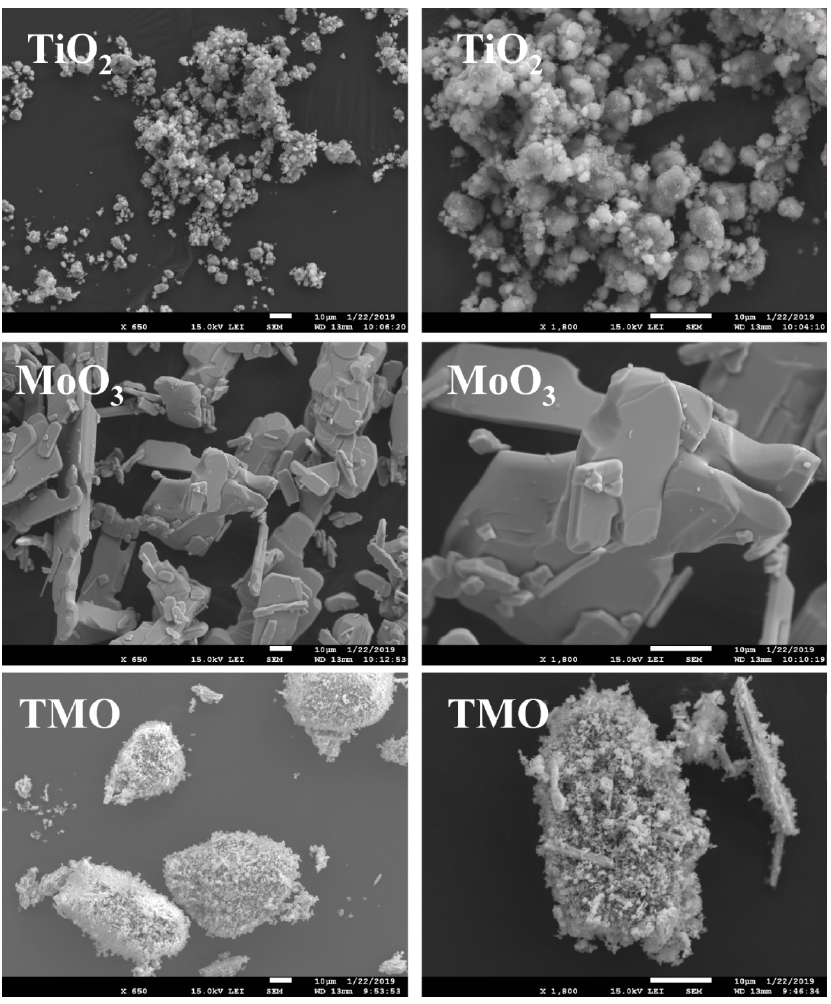
Figure 3. SEM images of starting (anatase TiO 2 and MoO 3 ) powders and TMO with the same magnifications ( left images: × 650, and right images: × 1800) for a better